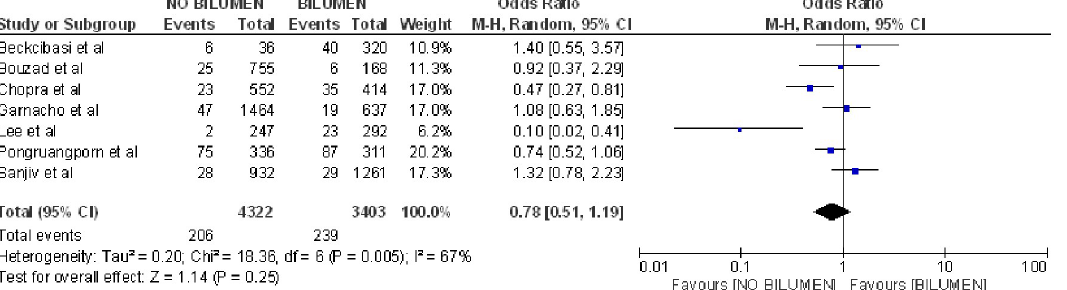
PLOS ONE | https://doi.org/10.1371/journal.pone.0282290 March 23,